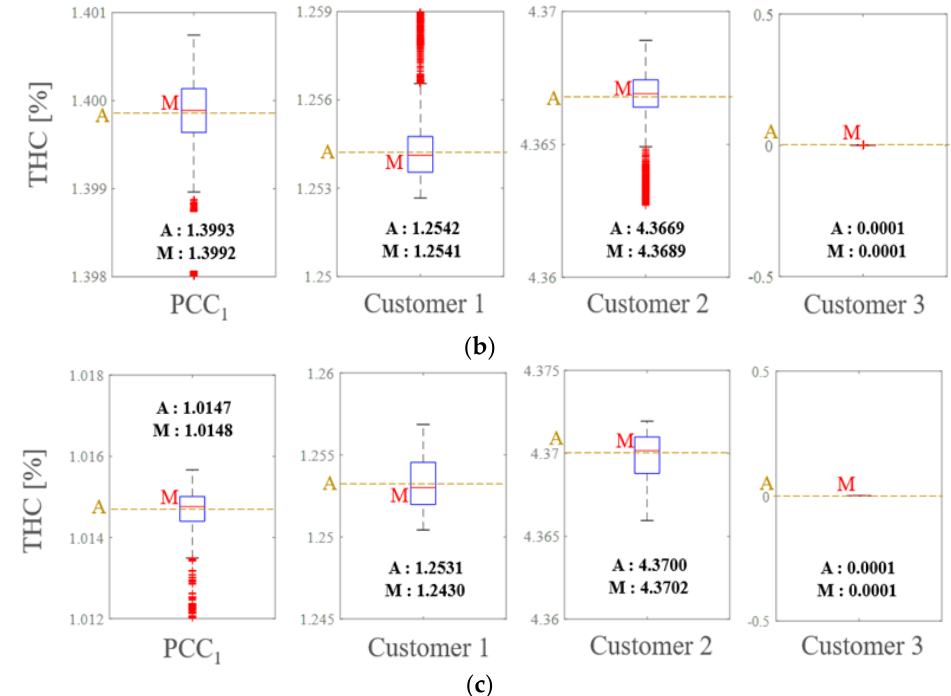
Figure 13. The results of the THC assessment for PCC 2 . ( a ) The average and median values of THC for the time section T1. ( b ) The average and median values of THC for time section T2. ( c ) The average and median values of THC for the time section T3.